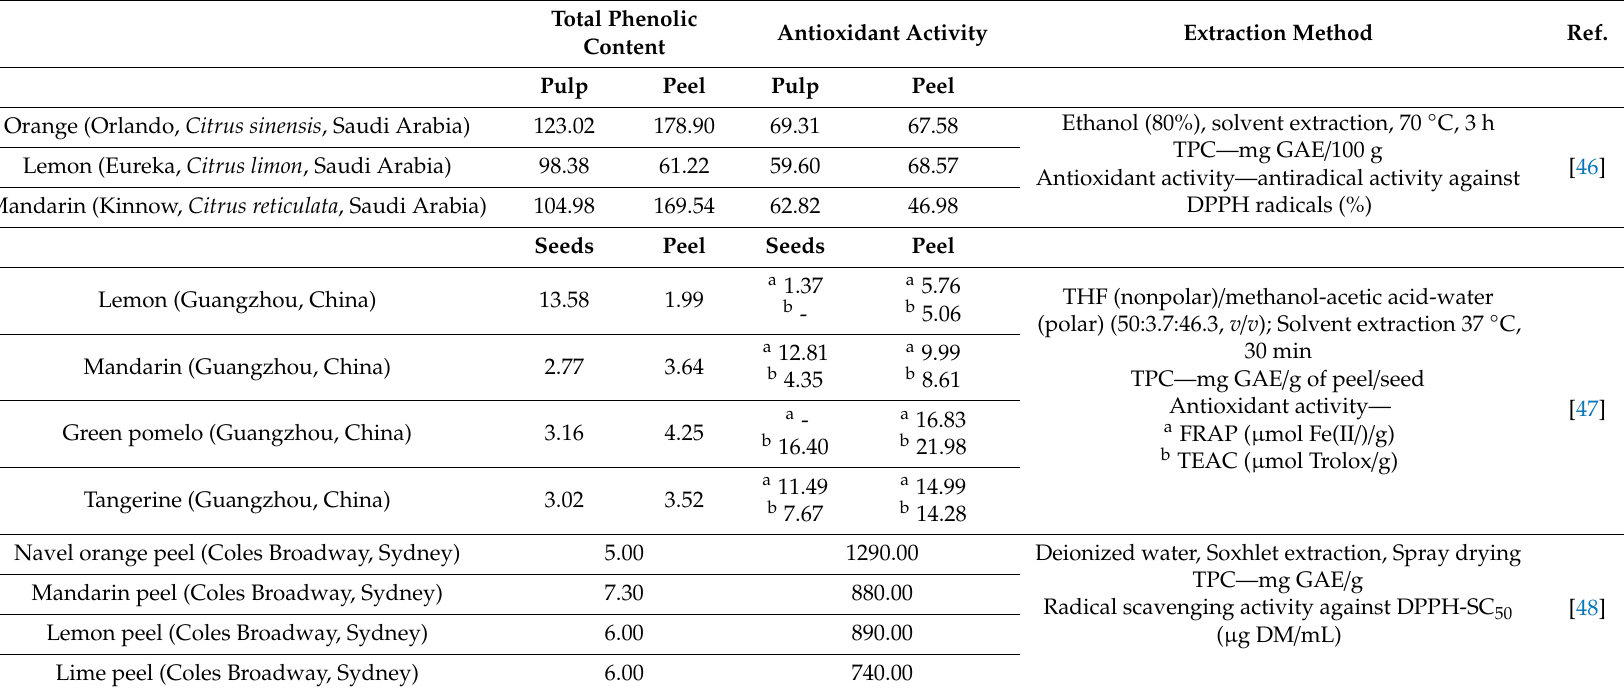
Table 3. Polyphenol content in di ff erent citrus varieties across the globe and the e ff ect of parameters involved in the extraction